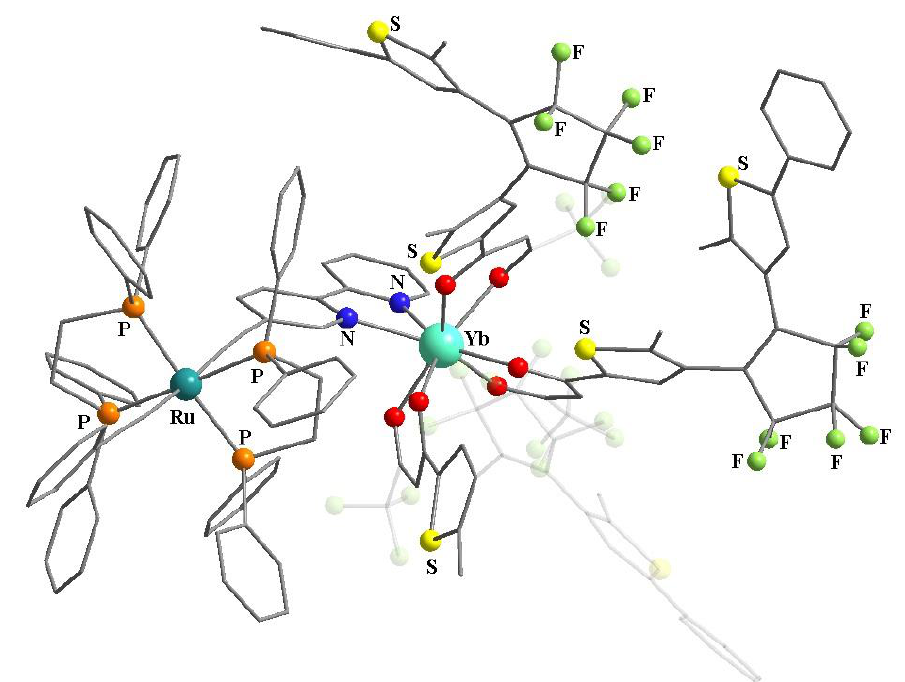
Molecules 2022 , 27 , x FOR PEER REVIEW 34 of 51 Figure 32. Molecular structure of 63 [51]. Hydrogen atoms have been omitted, some ligand groups are transparent for clarity. The cif has been retrieved from CCDC. CCDC number is 1959918. The Schiff base with two different coordination modes formed the heterometallic 3d- 4f binuclear complexes 65 (Scheme 27) [103,104]. The lanthanide(III) ions had an [LnO 8 ] environment, whereas 3d metals ions preferably coordinated with the less “hard” nitro- gen centers (Figure 33). The complexes with a combination of anisotropic Co(II) or Ni(II) ions with Tb(III) exhibited slow magnetic relaxation at low temperatures and, therefore, represented promising structures for single-molecular magnets ’ design [103]. On the other hand, the heterometallic complexes containing Zn(II) and Tb(III) or Eu(III) ions showed luminescent properties [104]. In this case, the replacement of the bridging acetate anion by 1-pyrenbutanoic acid (complex 66 , Figure 33) reduced the phosphorescence lifetime.